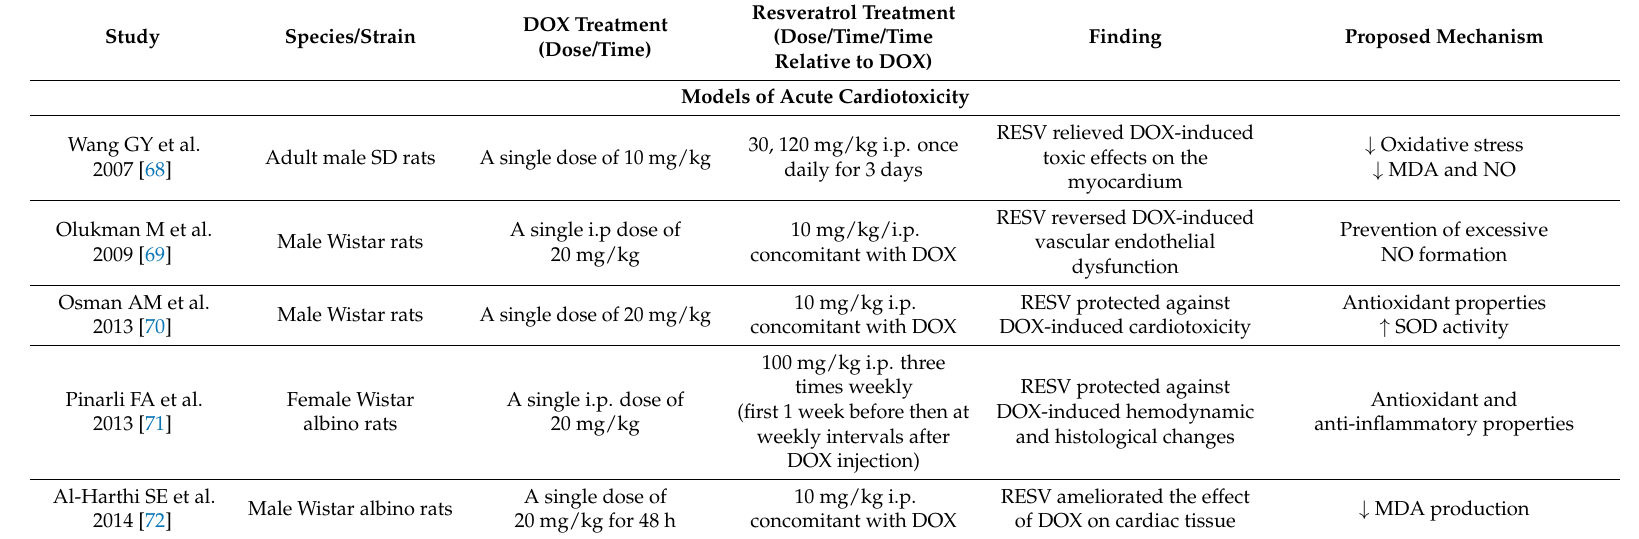
Table 2. In vivo studies demonstrating the cardio-protective effect of resveratrol against anthracycline-induced